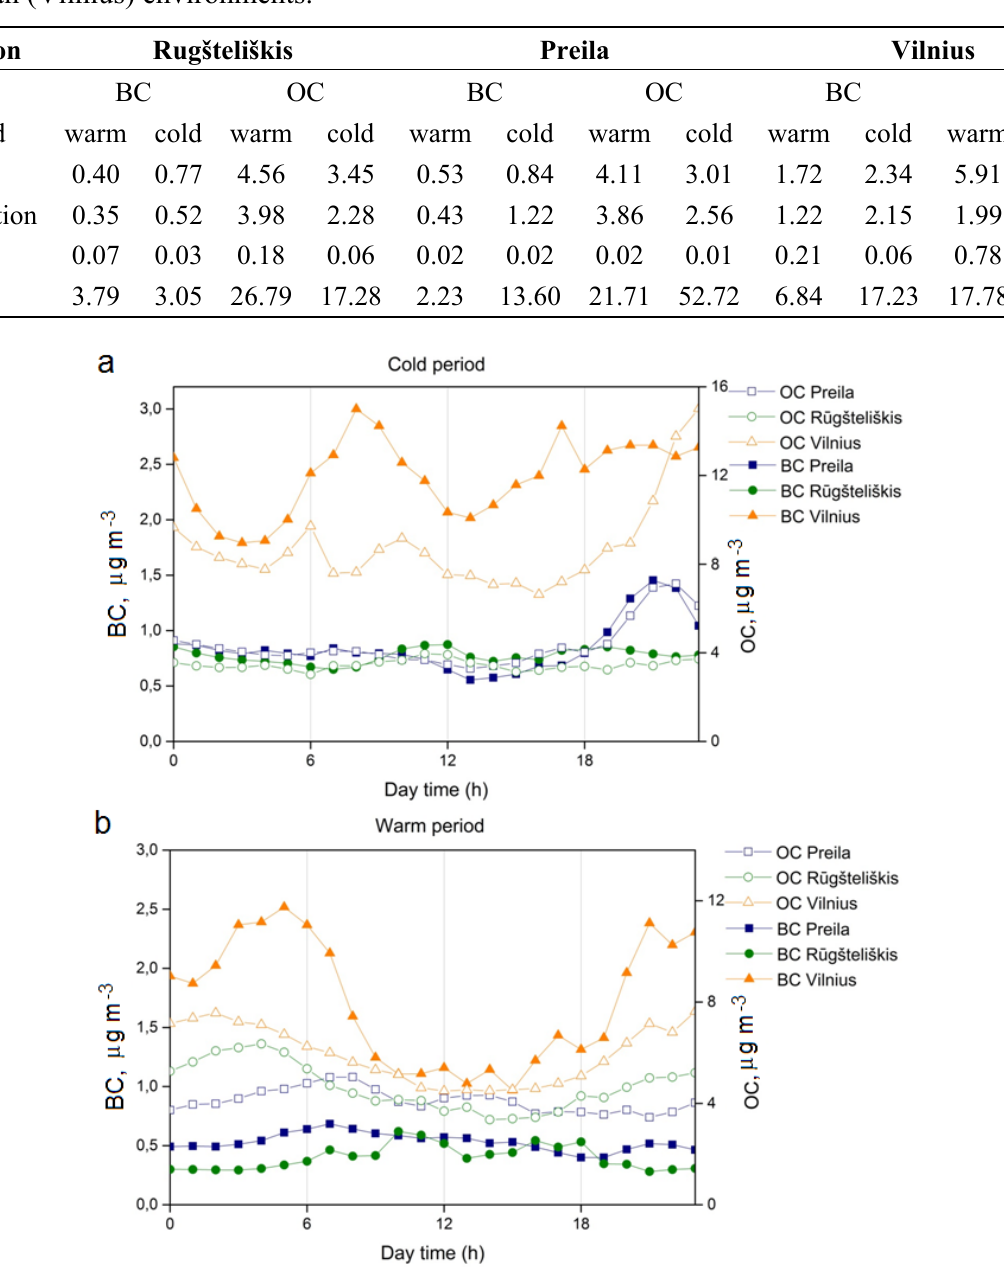
Figure 2. Mean diurnal variation of OC and BC mass concentrations during ( a ) cold and ( b ) warm periods in the rural (R ū gšteliškis), coastal/marine (Preila) and urban background (Vilnius)